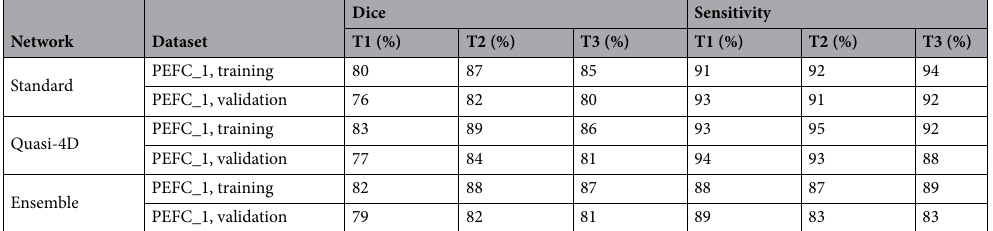
Table 2. Comparison of the classified water accuracy for the volumes at time steps T1, T2 and T3 computed between the SIRT-FBP-MD-D-DIFF and target volumes used for network training and validation. The target volumes were computed with the rSIRT-PWC-DIFF algorithm 17 . The results are shown separately for each MS-D network design, further split between the training and validation halves of the PEFC_1 fuel cell dataset. The classified water accuracy was measured through dice coefficient and sensitivity through the